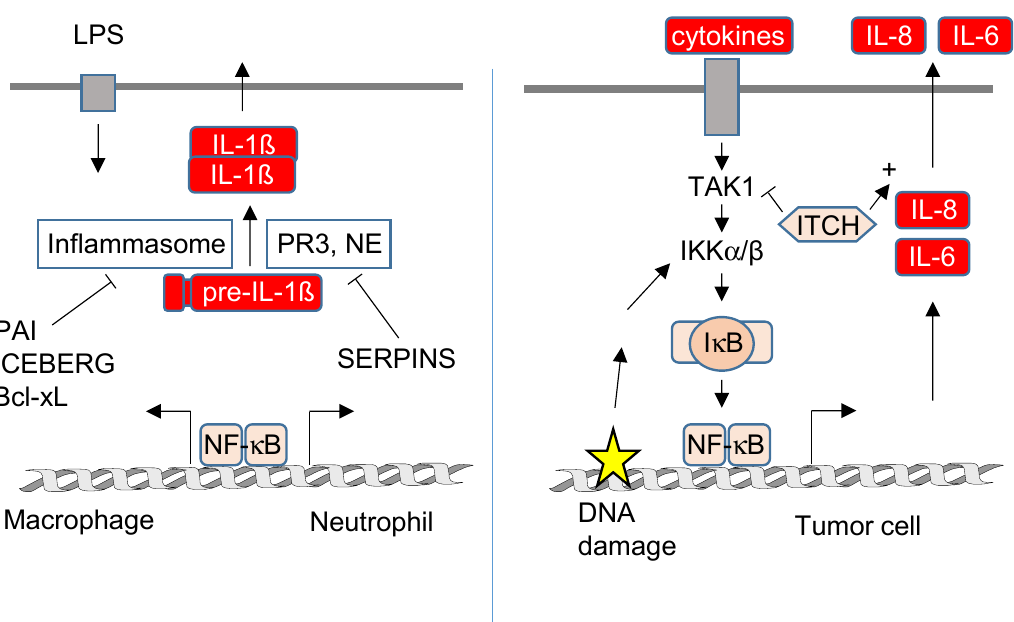
Figure 6. Regulation of protein secretion by NF- κ B. The left part visualizes the negative function of NF- κ B target proteins on pre-IL-1ß processing proteases and IL-1ß release in macrophages and neutrophils. The right part shows the contribution of ITCH to the NF- κ B pathways in senescent tumor cells that activate NF- κ B by autocrine mechanisms and by ongoing DNA damage. ITCH also supports secretion of IL6 and IL8 by unknown mechanisms.